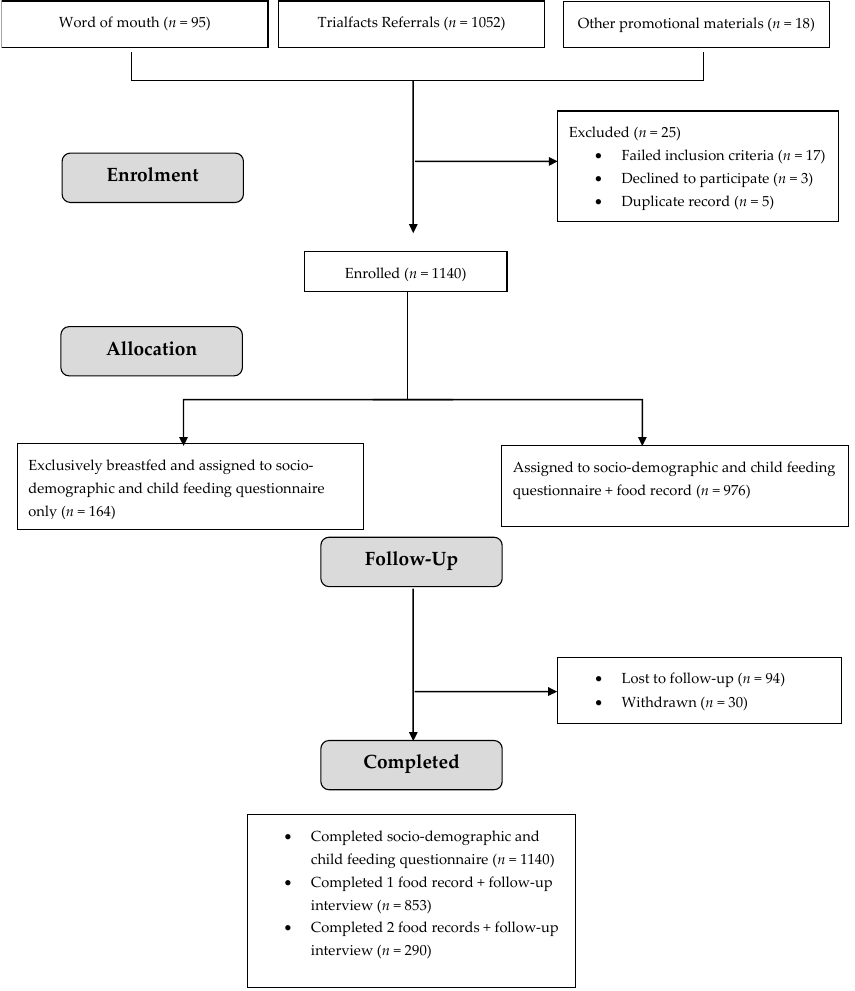
Figure 1. Participant flow and follow-up for OzFITS 2021.